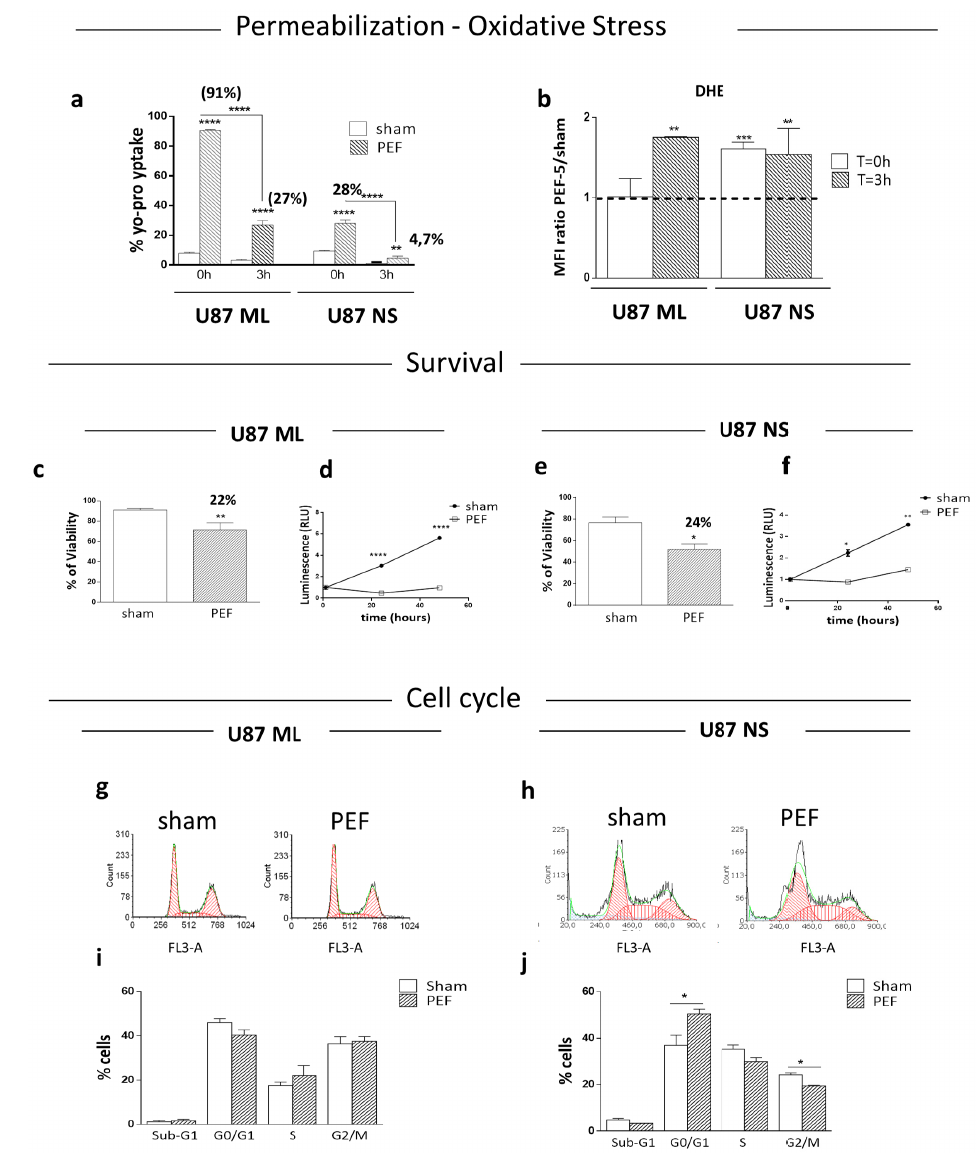
Figure 2. Membrane permeabilization, ROS production, cell survival and cell cycle. ( a ) Yo-pro-1 uptake at T = 0 h and at T = 3 h after PEF-5 exposure in U87 ML and U87 NS cells. ( b ) ROS levels after PEF-5 exposure at T = 0 h and T = 3 h. The histogram shows the ratio between the mean fluorescence intensity (MFI) of exposed and sham-exposed cells in both cell culture conditions. ( c – e ) Bar graphs of sham-exposed and exposed U87 ML and NS cells 24 h after PEF-5 exposure for cell death quantification (Trypan blue assay). ( d – f ) Cell proliferation evaluated at different time points (0, 24 and 48 h) after PEF-5 exposure in U87 ML and U87 NS. ( g – j ) Cell cycle phases in U87 ML and NS at 24 h after PEF-5 exposure. p values were determined using a two-tailed t test. * p < 0.05; ** p < 0.01; *** p < 0.001; **** p <